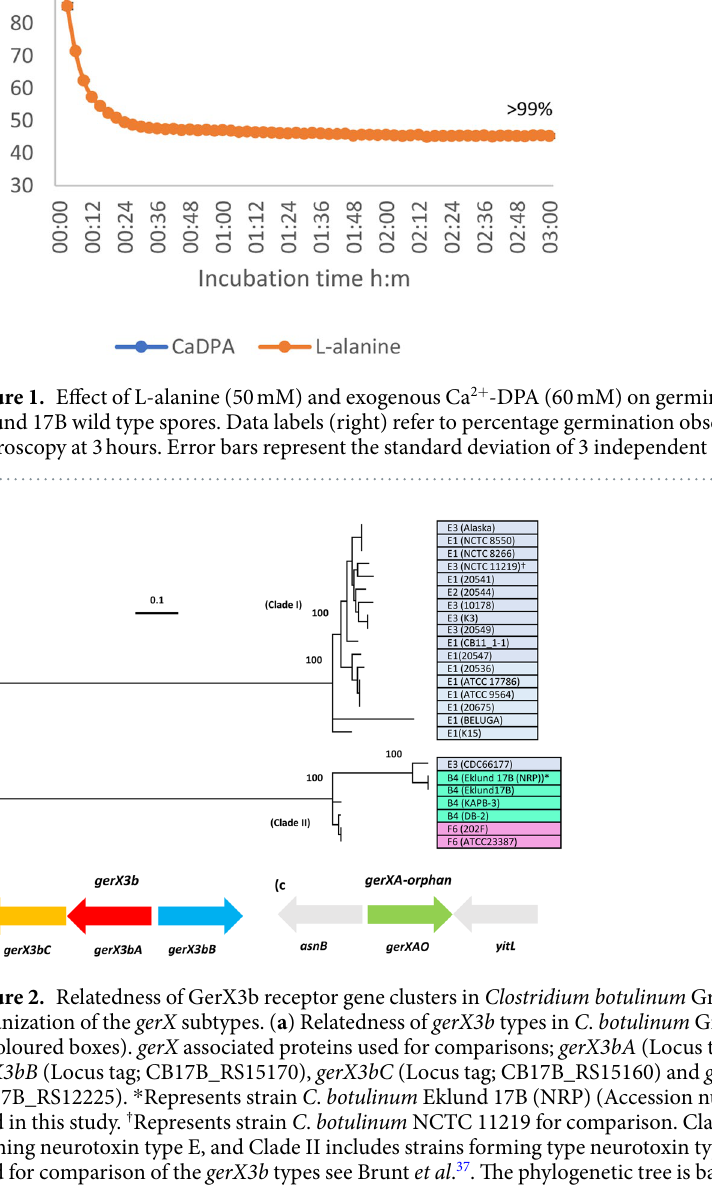
Eklund 17B is located in clade two in Fig. 2a (while the gerX3b germinant receptor in strain NCTC 11219 studied by Clauwers 40 is found in clade one). Clade one exclusively contains strains forming type E neurotoxin, while